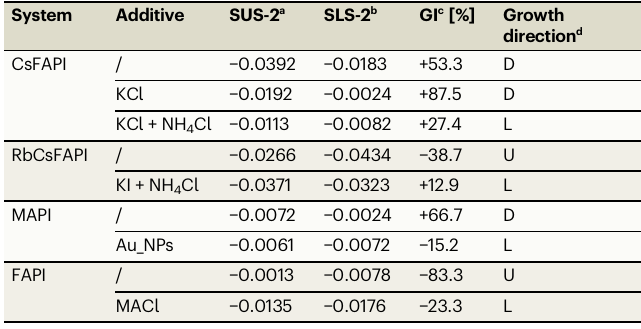
Table 2 | Slope parameters for various precursor solution compositions